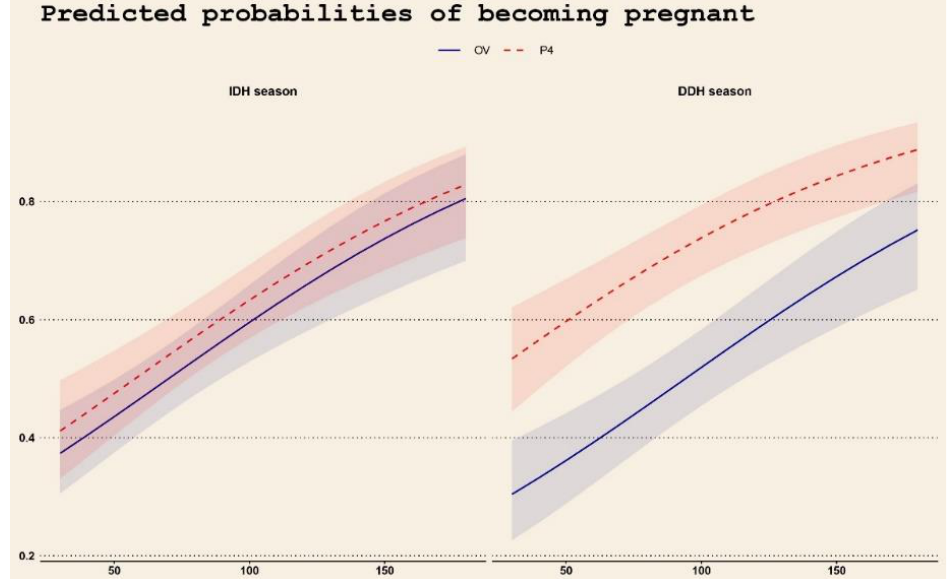
Figure 3. Marginal effects of dip regressor (horizontal axis) over seasons (panels) and treatments (lines) on the predicted probabilities of becoming pregnant in primiparous buffaloes synchronized by Ovsynch (OV) or Progesterone based treatment (P 4 ) that underwent AI during periods characterized by Increasing Daylight Hours (IDH) and Decreasing Daylight Hours (DDH).